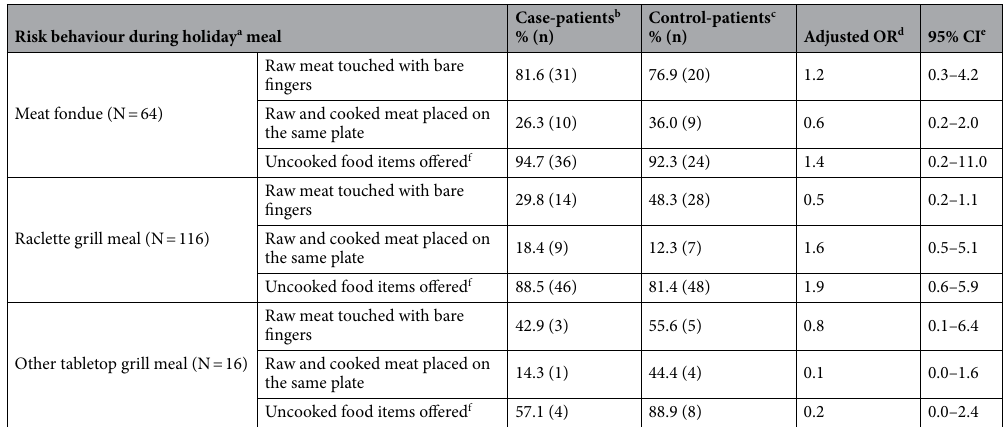
group and sex). Statistically significant odds ratios ( P -values ≤ 0.05) are depicted in bold. e Confidence interval.